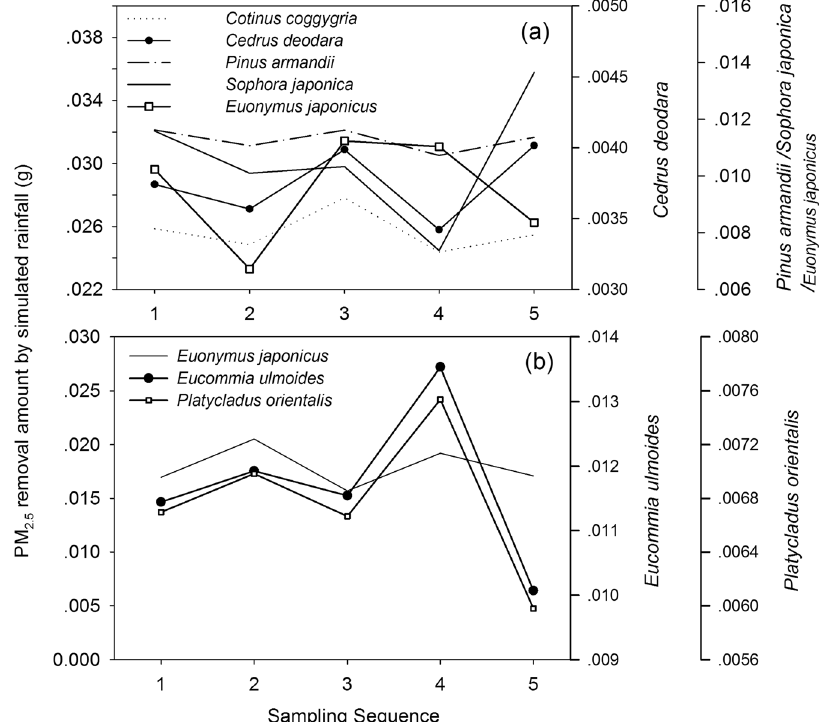
Figure 6. Progression pattern of foliar PM 2.5 removal by simulated rainfall (equivalent to 7.5 mm outdoor rainfall, over 15 minutes). The sampling time interval was 3 minutes. Sampling sequence from 1 to 5 represented samples taken at 3 minutes, 6 minutes, 9 minutes, 12 minutes and 15 minutes, respectively, from the start of simulated